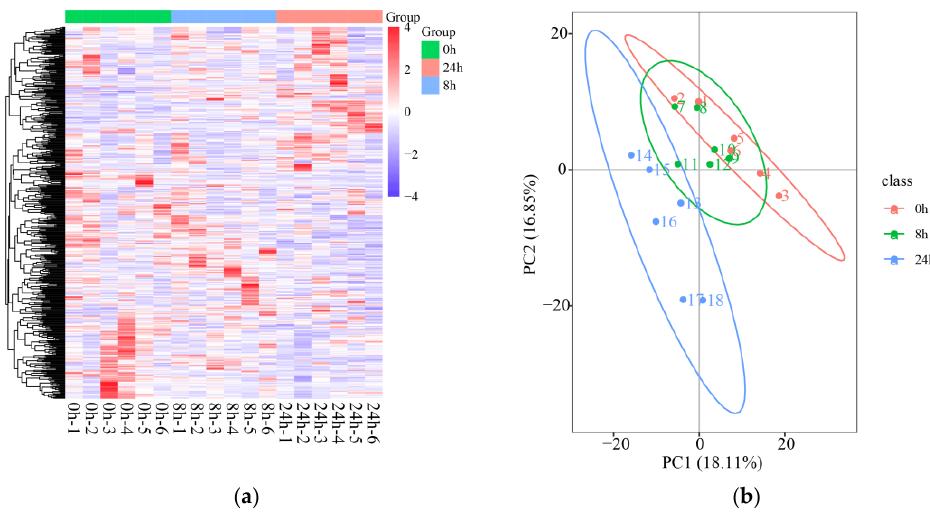
Figure 4. Quality control chart of metabolome data in the roots of orchardgrass under submergence stress. ( a ) Total metabolite hierarchical clustering heat map. ( b ) PCA analysis of the expression of metabolites for 0 h, 8 h, and 24 h.